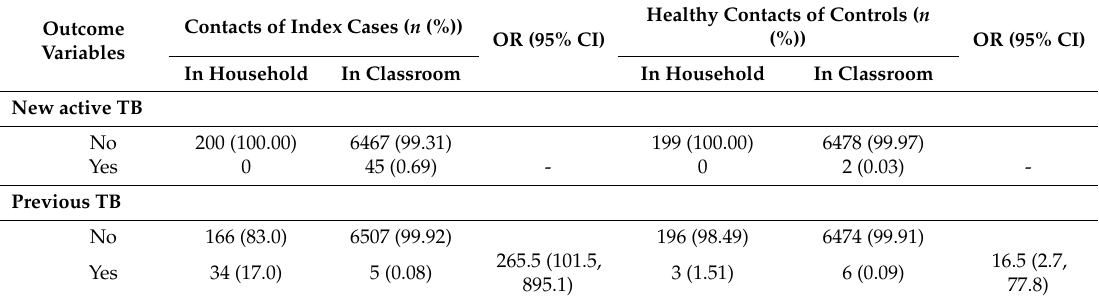
Table 4. New active TB and previous TB among contacts of index case and healthy